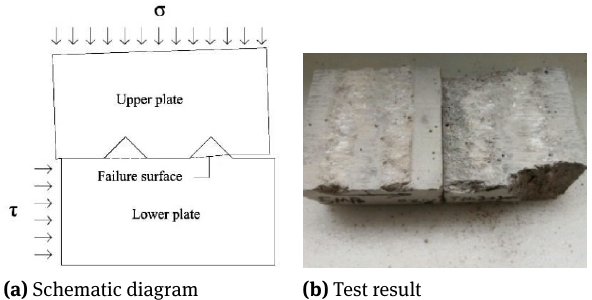
Figure 6: The coupling effect of overriding and cutting